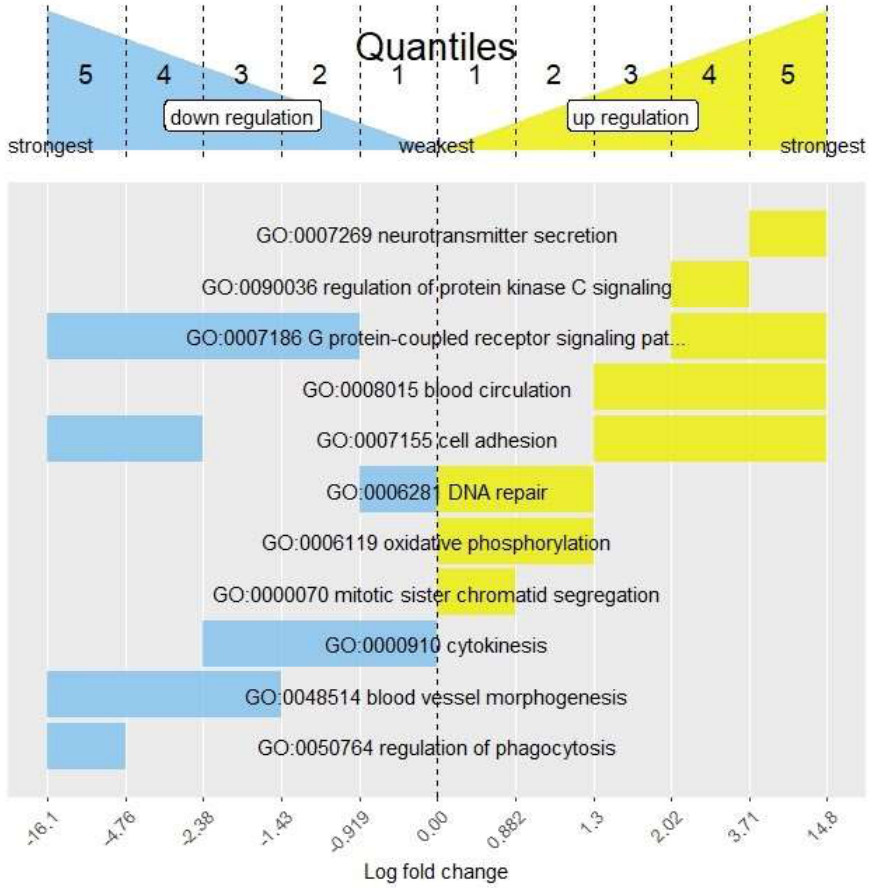
Figure 4. The FoldGO output data for comparison of gene expression between primary prostate epithelial cell line (HPrEC) and prostate adenocarcinoma cell line (LNCaP). The chart provides the fold-change intervals detected by Fold-change-Specific Enrichment Analysis (FSEA) where selected Gene Ontology (GO) terms (the whole list is in Table S2) showed the most significant enrichment compared to the whole Differentially Expressed Genes (DEGs) list. Bars for fold-change-specific GO terms are painted in yellow and blue colors for up- and down-regulated processes, correspondingly.